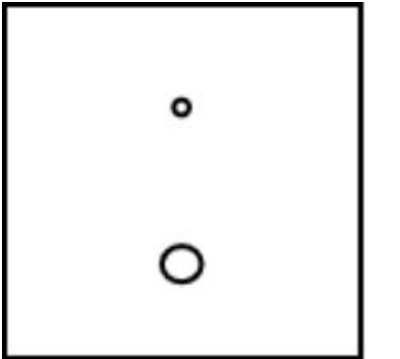
Figure 2. The window filter design. The upper window is 50 μm and the lower window is 5 mm; the distance is 10 mm.